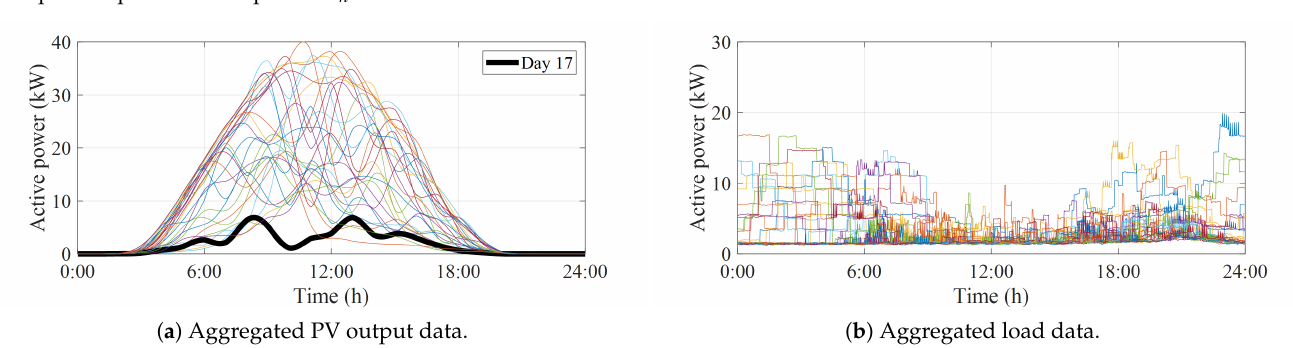
(cid:48) . The profiles are derived on the basis of 0